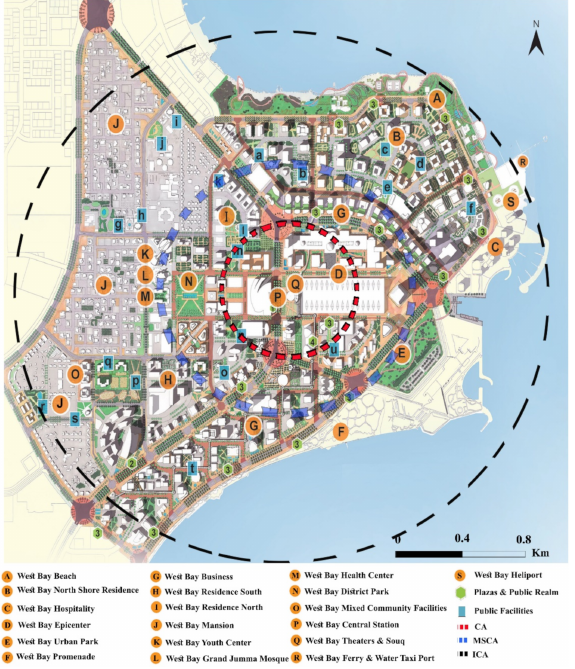
Figure 13. West Bay Concept